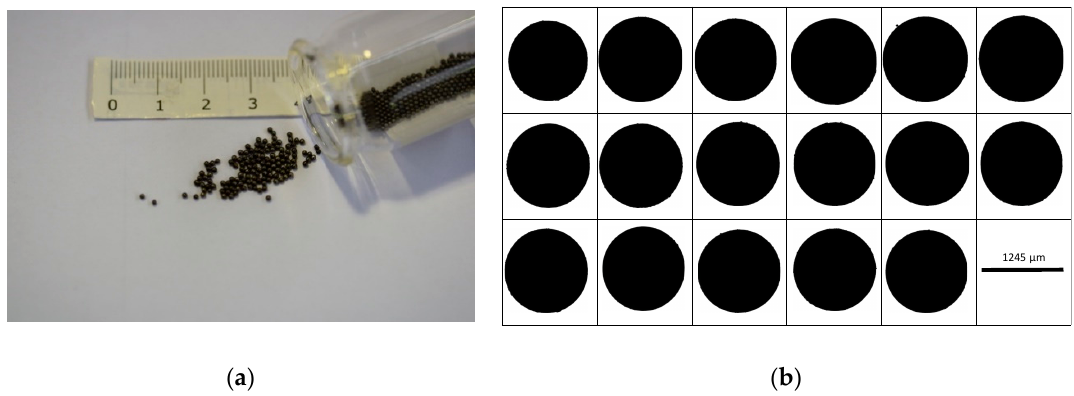
Figure 6. ( a ) Generated 100Cr6 particles after being cleaned and dried. ( b ) Overview of 17 different particles under G3 device.